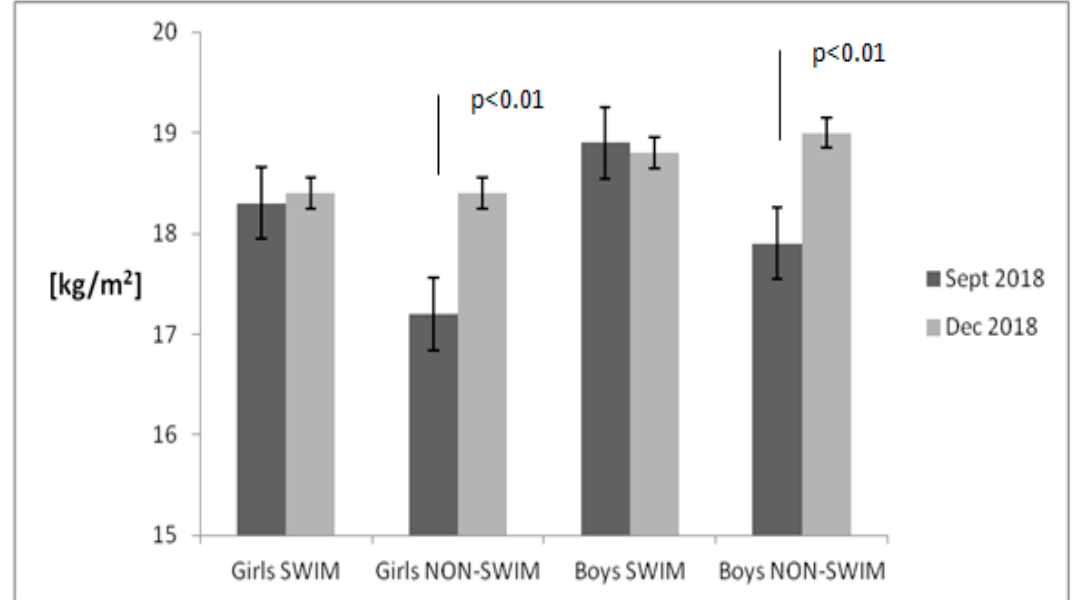
Figure 3. Body mass index (BMI) changes in the examined groups of children. Data are presented as mean value and standard error. The non-swimmers group consisted of children participating in team sports (soccer, basketball), athletics, martial arts and dance.